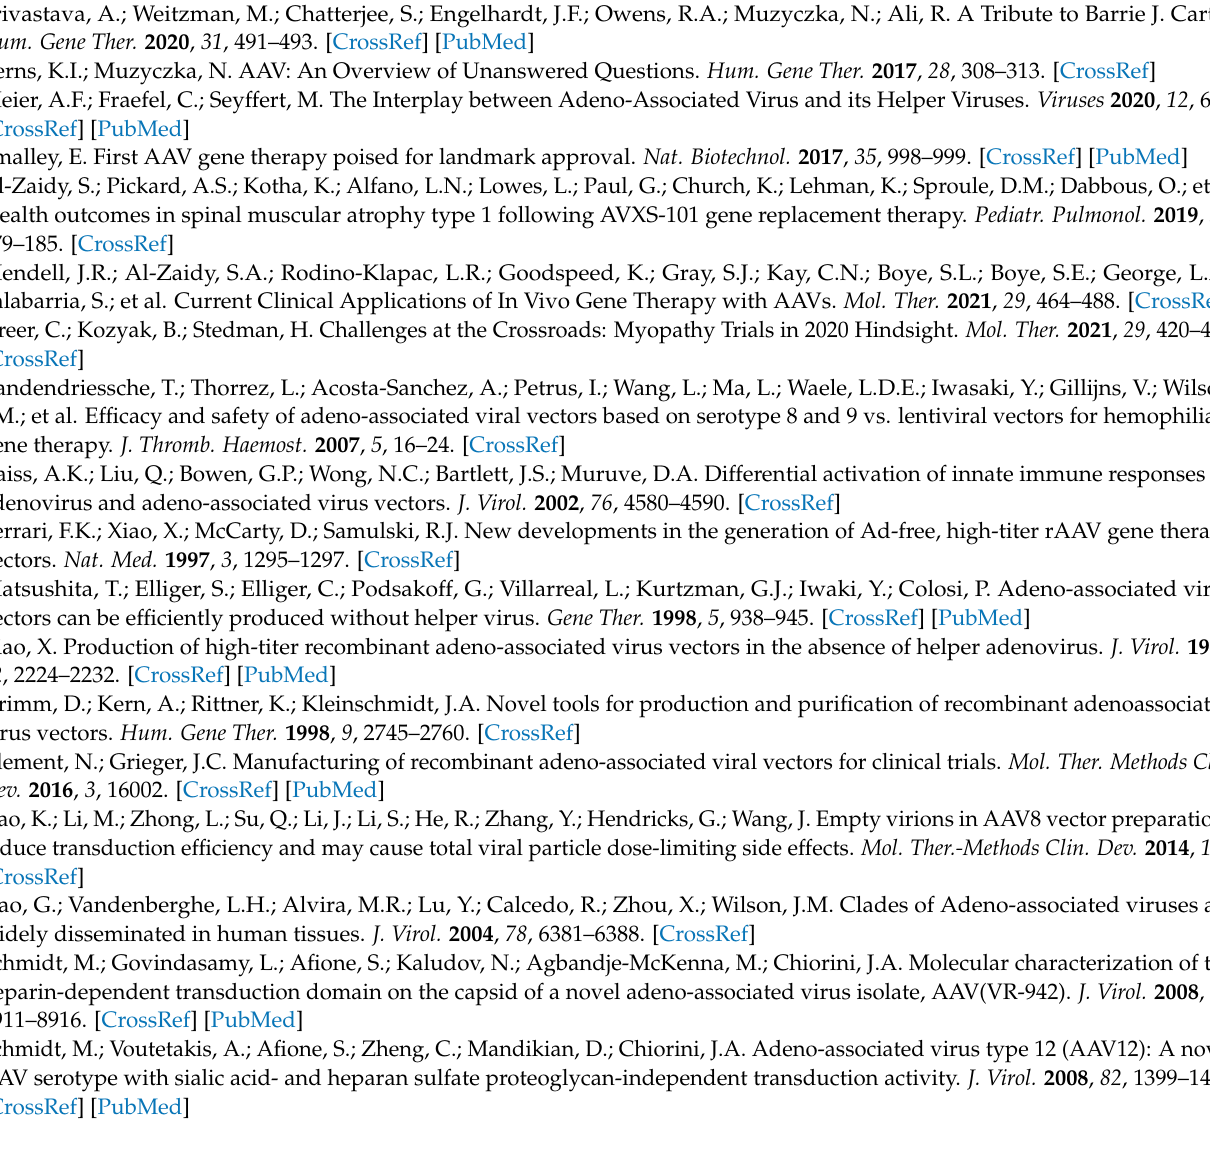
Table S2: AAV Tropism